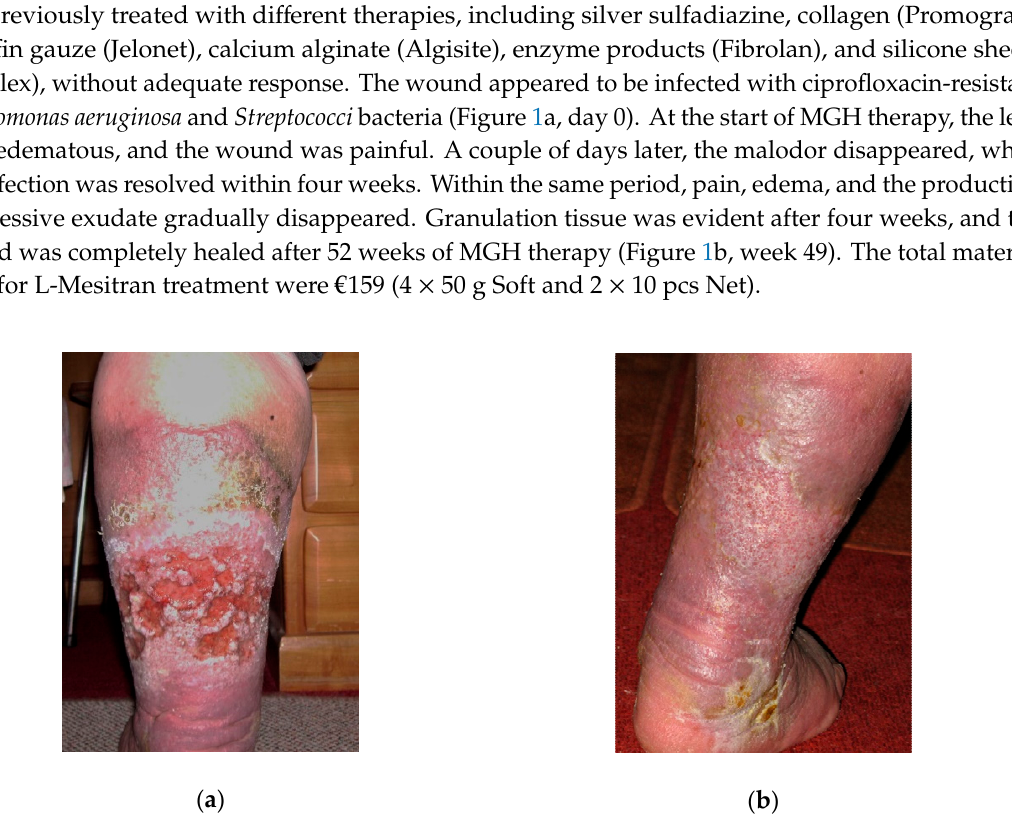
Figure 1. Case 1: ( a ) the wound at the start of medical-grade honey (MGH) therapy (day 0); ( b ) complete healing of the wound after 49 weeks of MGH therapy.